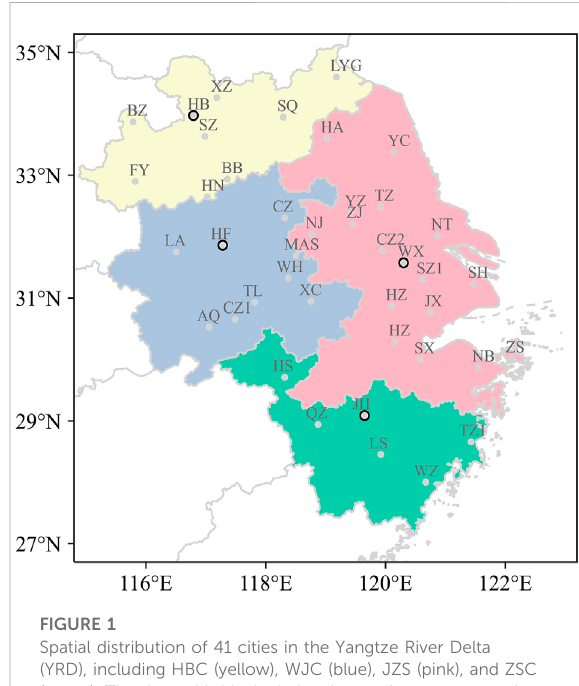
FIGURE 1 Spatial distribution of 41 cities in the Yangtze River Delta (YRD), including HBC (yellow), WJC (blue), JZS (pink), and ZSC (green). The dots with black circles denote four representative cities (Table